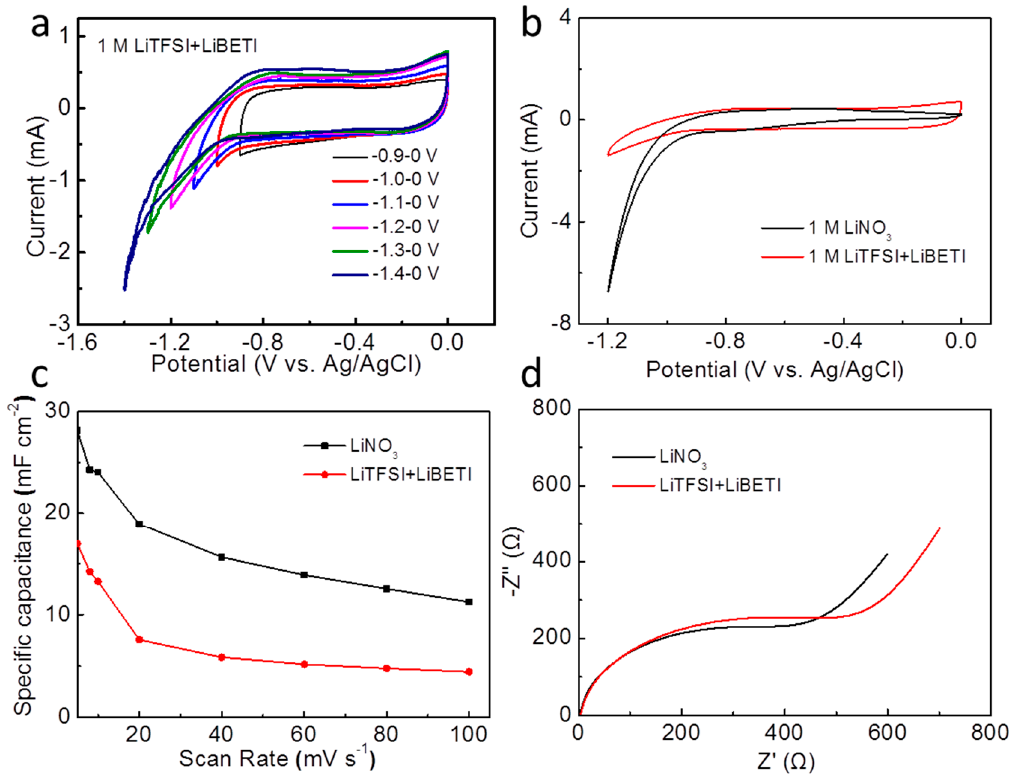
Figure 6. CV curves of the Fe 2 O 3 @CC electrode: by increasing the negative potential limit from − 0.9 to − 1.4 V in 1 M LiTFSI + LiBETI ( a ), from − 1.2 and 0 V in LiNO 3 and LiTFSI + LiBETI ( b ), variation of the specific capacitance with the scan rates ( c ), the Nyquist plots of the Fe 2 O 3 @CC electrode in LiNO 3 and LiTFSI + LiBETI( d ).